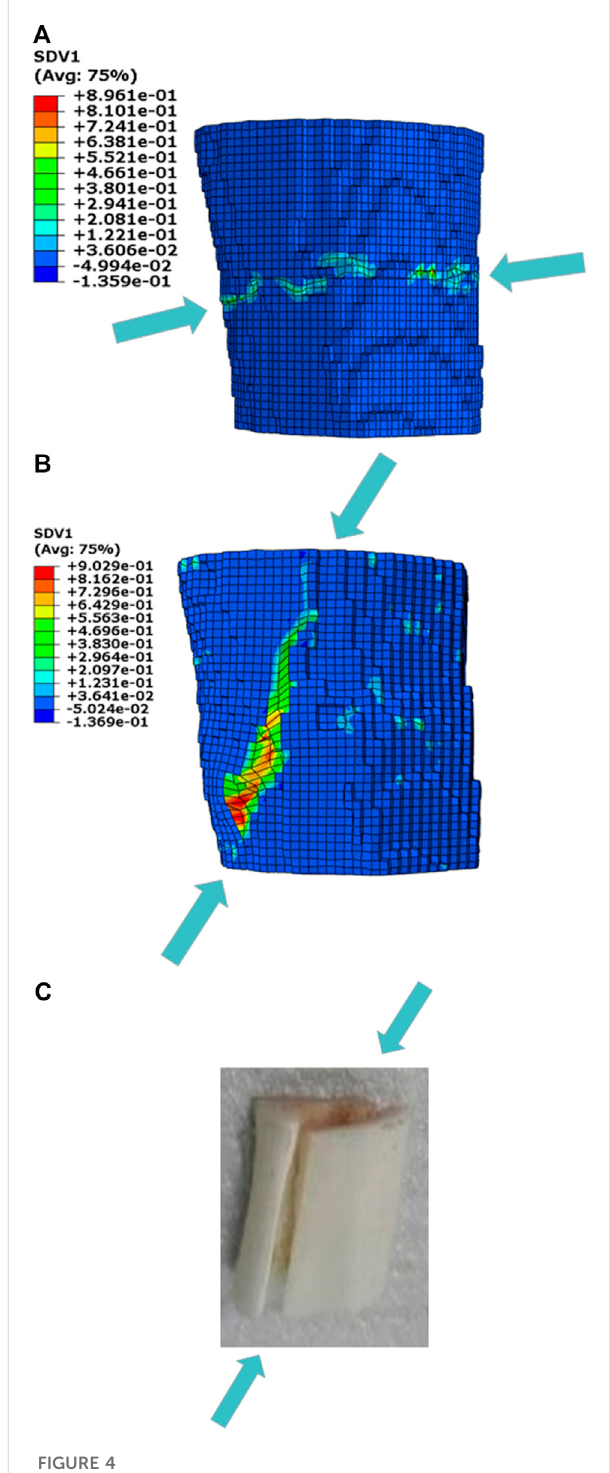
Comparison of the fracture patterns in the simulations and compressive experiment (A) Fracture simulation predicted by applying the equivalent strain; (B) Fracture simulation predicted by applying the minimum principal strain; (C) Compressive